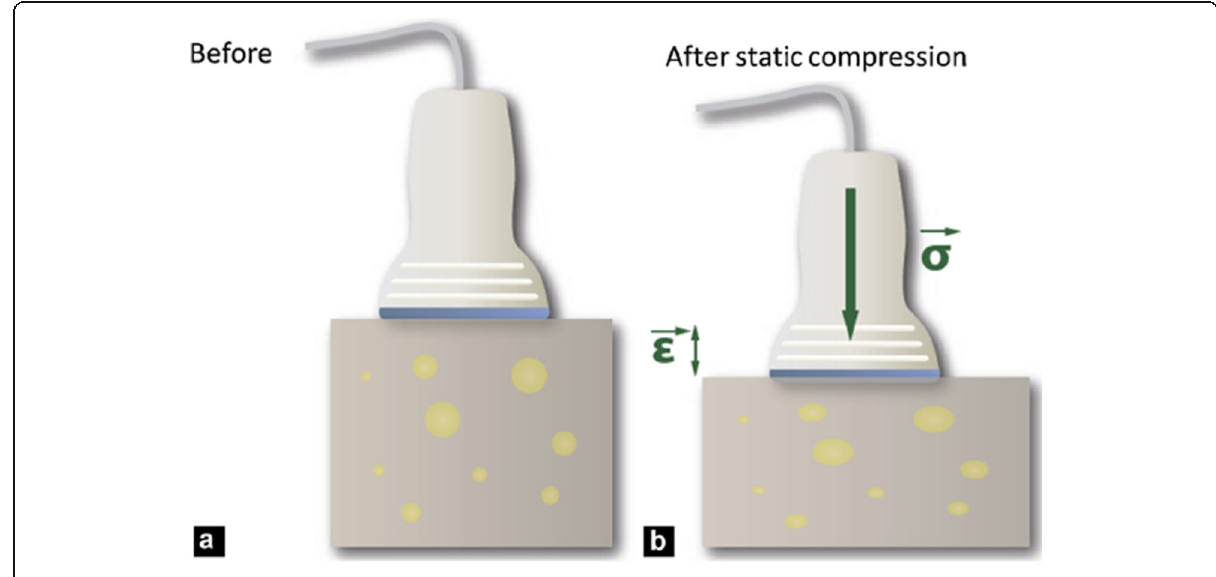
wave velocity is simultaneously manifested and con- verted to an image. The repeatability of this method is high. When a region (ROI) is selected, pre-compression is removed and two-dimensional SWE is turned on. The patients must remain static during the acquisition of in- formation. Color scales are considered for the lesions observed [28] (Figs. 11 and 12).